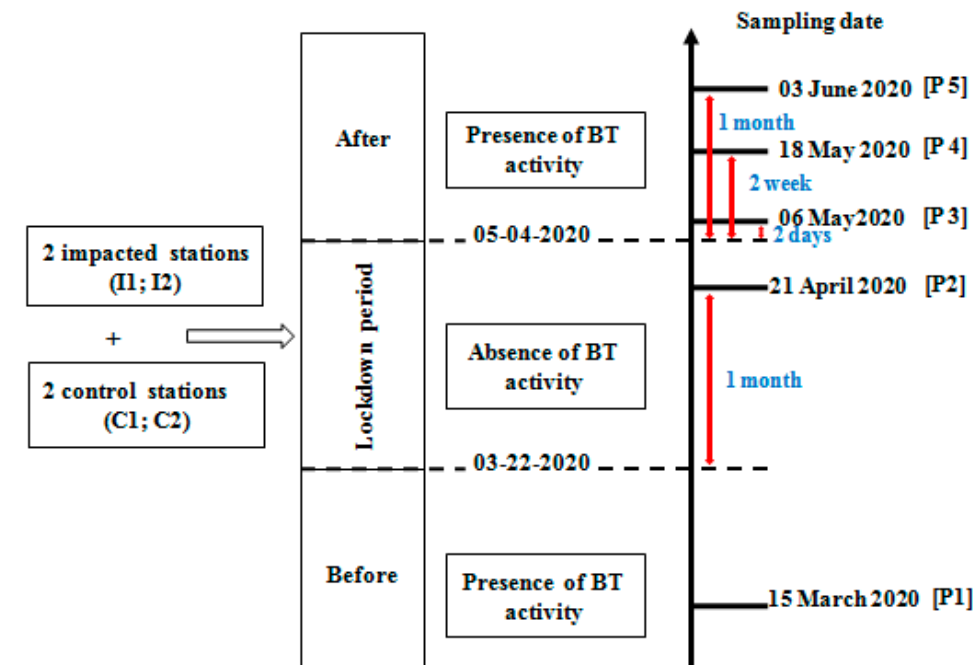
Figure 2. Representation of the sampling strategy used in this study during the five sampling periods, with P1: before lockdown; P2: during lockdown; P3: after two days; P4: after two weeks; P5: one month after the lockdown; and BT: bottom trawling.